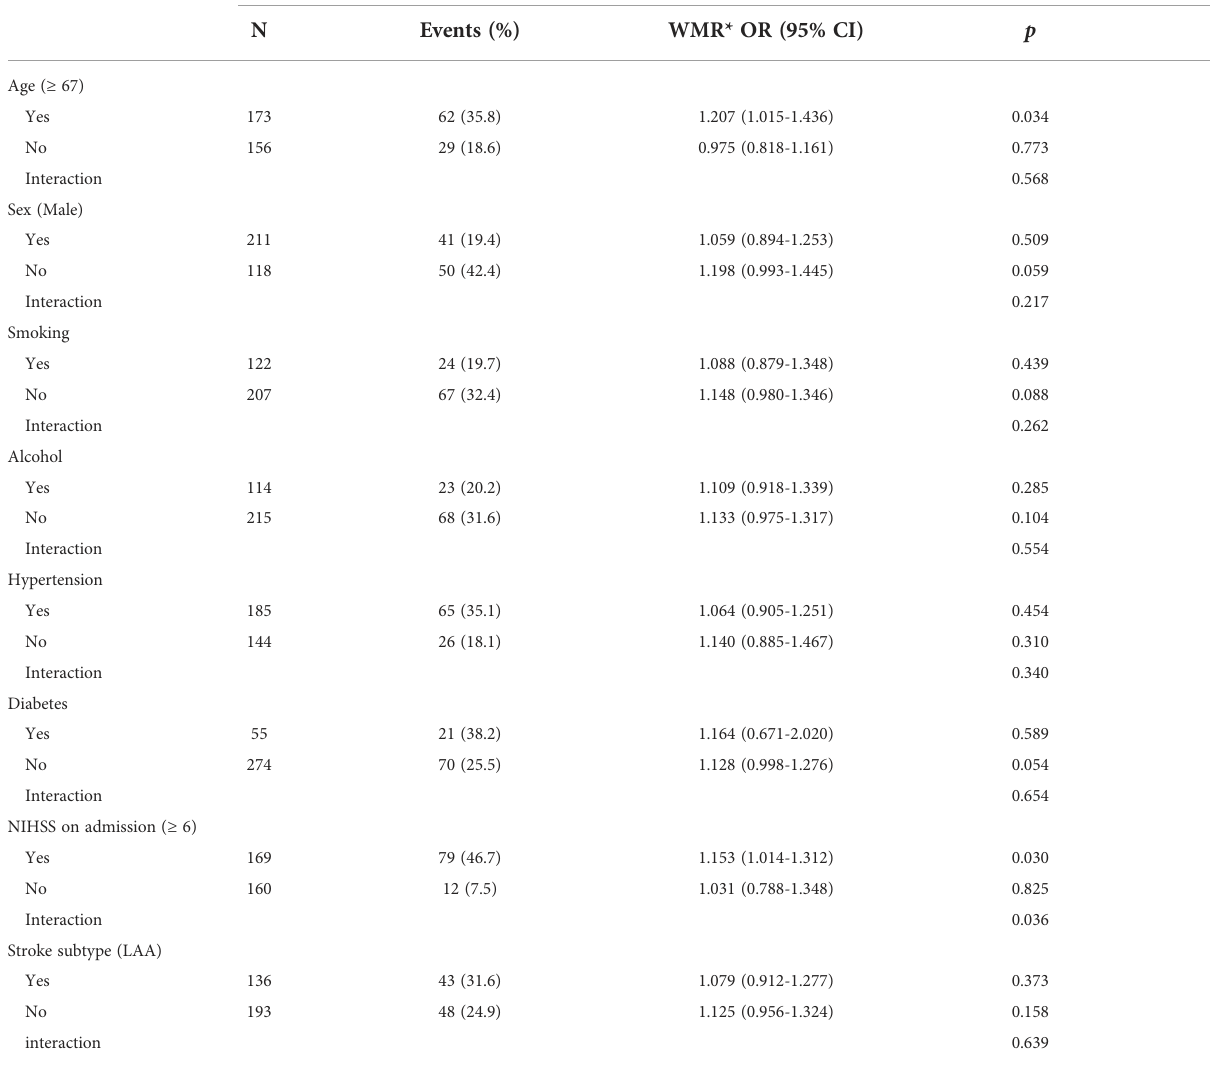
TABLE 4 Subgroup analyses of the association between WMR and primary outcome (death or major